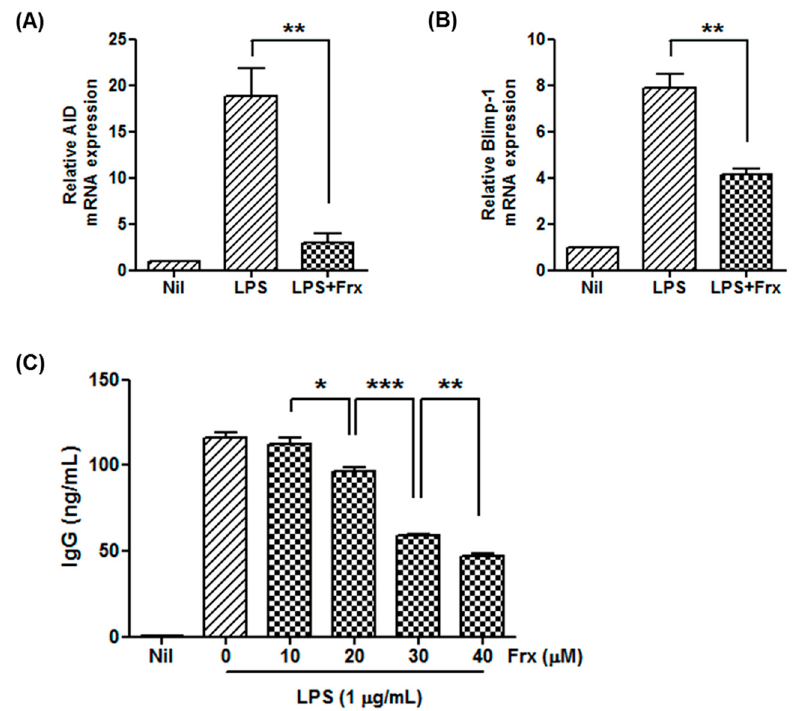
Figure 3. Fraxinellone inhibits B cell maturation. ( A , B ) CD19 + B cells were activated by lipopolysaccharide. After treatment with or without fraxinellone (40 μ M), the relative expression levels of AID and Blimp-1 in CD19 + B cells were determined with RT-PCR. ( C ) The level of immunoglobulin G in the culture supernatant was measured using ELISA in the presence of fraxinellone at doses of 0–40 μ M. In all culture conditions, CD19 + B cells were stimulated by lipopolysaccharide. Data represent the mean of three independent experiments ± SEM. Nil, no stimulation; LPS, stimulation with lipopolysaccharide; Frx, fraxinellone; AID, activation-induced cytidine deaminase; Blimp-1, B lymphocyte-induced maturation protein-1; IgG, immunoglobulin G; * p < 0.05; ** p < 0.01; *** p < 0.001.